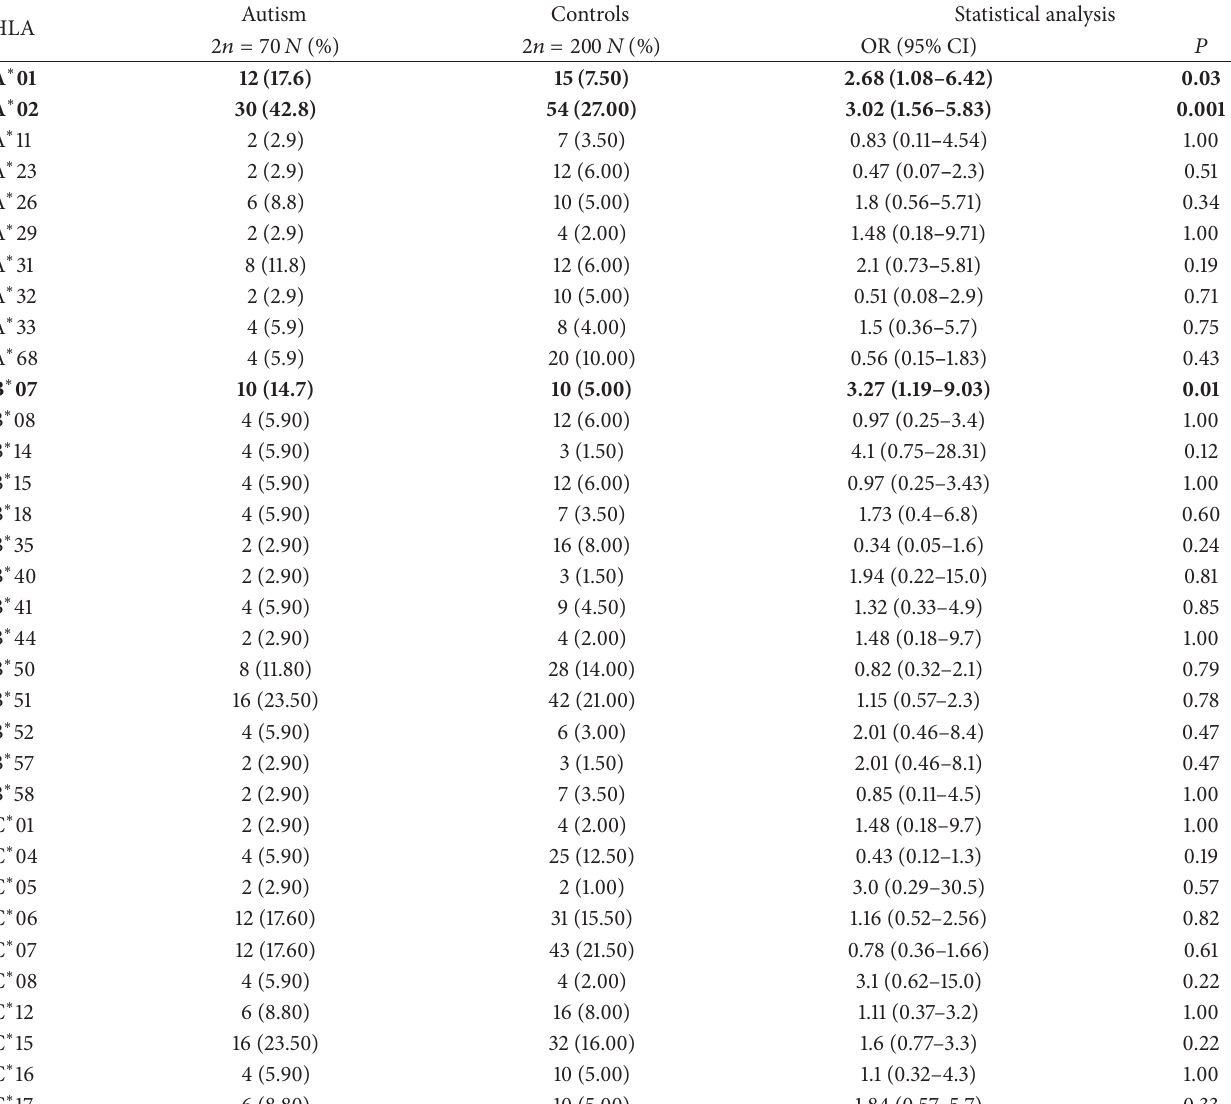
Table 1: HLA-A ∗ , -B ∗ , and -C ∗ allele frequencies in autistic children and